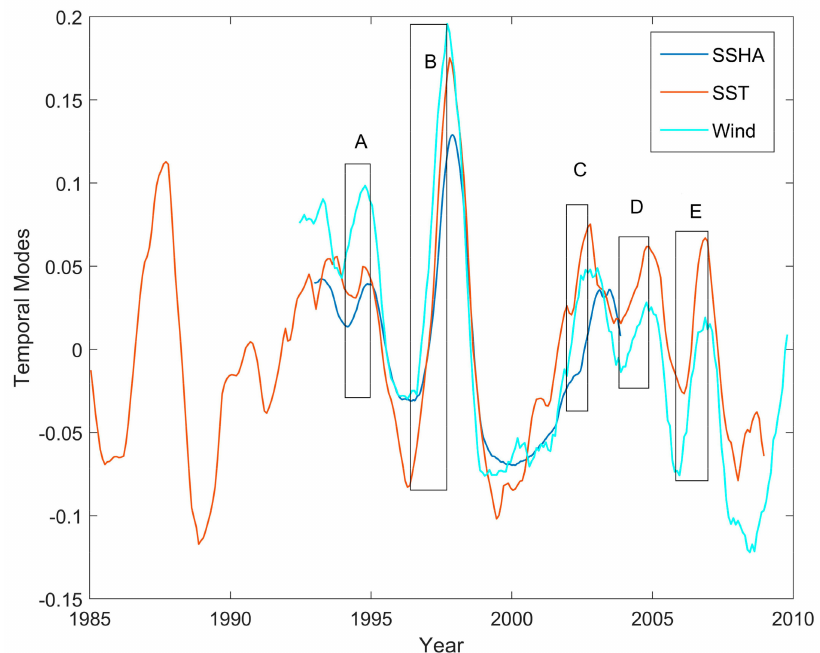
Figure 2. The first temporal EOF modes of wind vector, SST, and SSHA. These temporal EOF modes are normalized values with arbitrary units. The time spans of A (January 1994 to December 1994), B (May 1996 to August 1997), C (November 2001 to August 2002), D (October 2003 to October 2004), and E (October 2005 to November 2006) specify developing periods of El Nino events. Table 2. Lead time (in months) of the wind in relation to SST and SSHA for the EOF temporal modes. A B C D E Wind leads SST 4.2 2.3 2.2 0.3 1.2 Wind leads SSHA 3.6 2.5 6.6 -